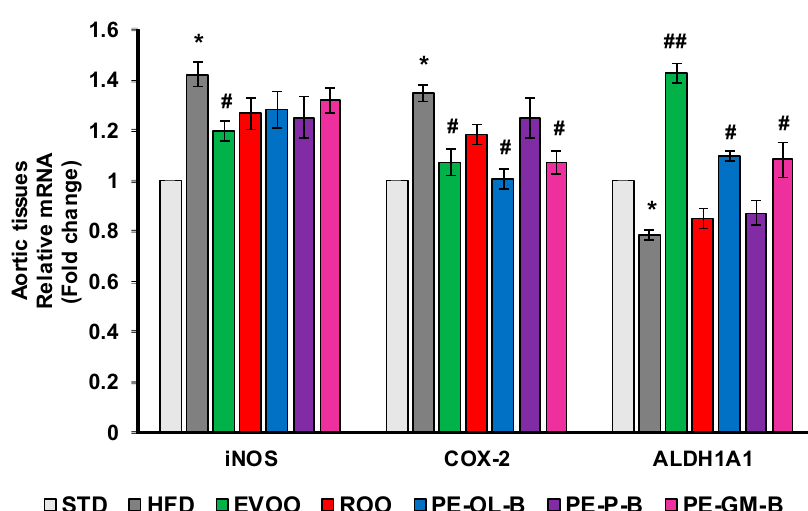
Figure 8. Diet supplementation of HFD fed rats with EVOO, ROO, PE-OL-B, PE-P-B, and PE-GM-B affects mRNA expression of inflammatory enzymes and ALDH1A1. Data are determined by the comparative Ct method ( ∆∆ Ct) normalized to GAPDH expression and reported as fold change vs. STD group which was assigned to 1. Data are means ± SD ( n = 3). * p ≤ 0.05 vs. STD; # p ≤ 0.05 vs. HFD; ## p ≤ 0.01 vs. HFD.